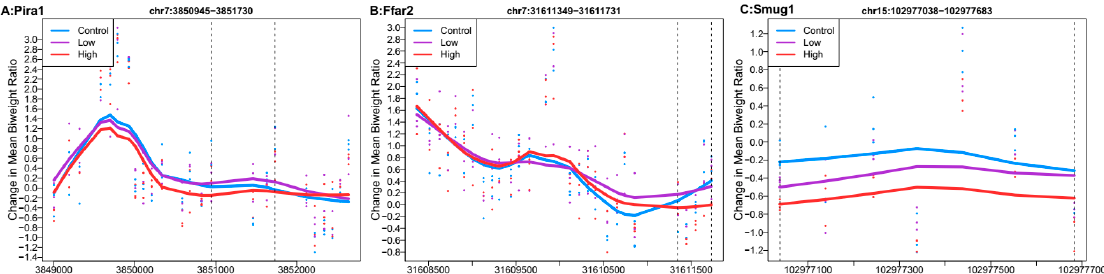
Figure 3. Di ff erentially methylated regions overlapping between high (32 ppm) and low perinatal Pb exposure. Regions within dashed lines indicate the di ff erentially methylated region. Areas outside the boundary are plotted to show the trend outside the region. Nearest gene to regions: ( A ) Paired-Ig-like receptor A1 ( Pira1 ), chromosome 7: 3850945-3851730. ( B ) Single-strand selective monofunctional uracil DNA glycosylase ( Smug1 ), chromosome 7:31611349-31611731. ( C ) Free fatty acid receptor 2 ( Ffar2 ), chromosome 15:102977038-102977683.